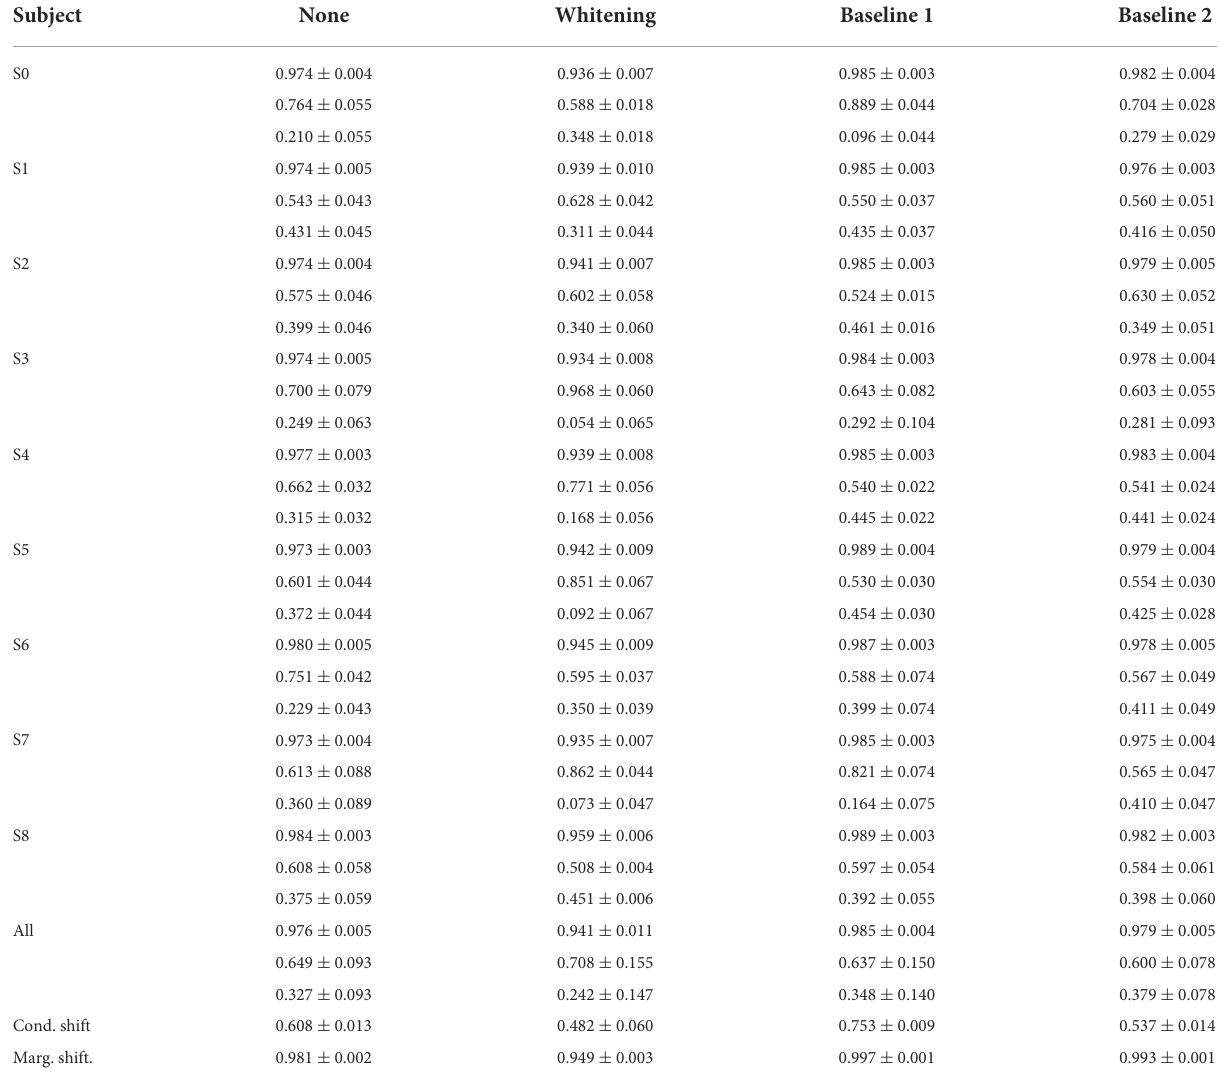
TABLE 1 Results of binary mental workload classification with leave-one-subject-out cross validation for subjects that performed physical activity on the